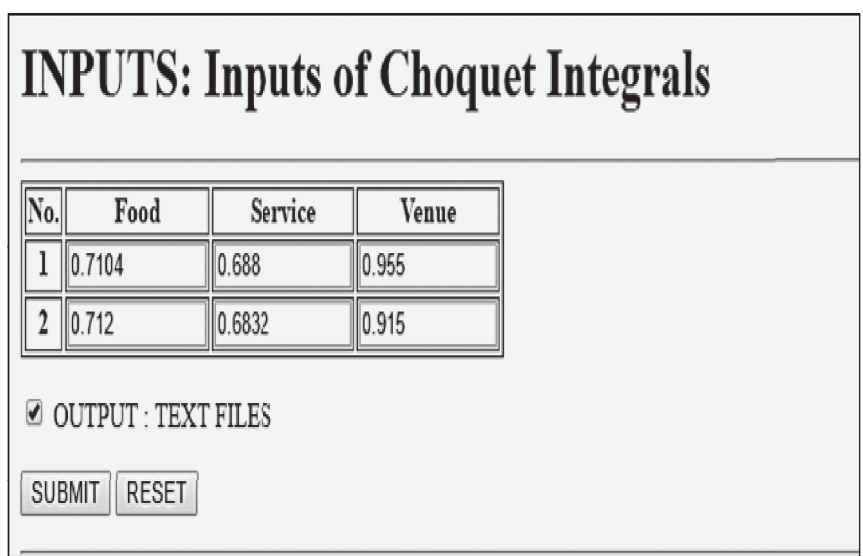
Figure 2: Output of Choquet integral.